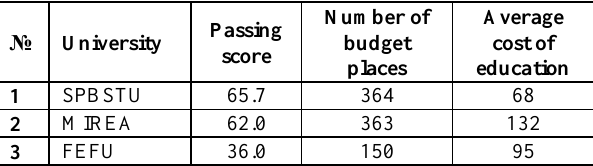
Table 6 – University evaluation indicators by free access data